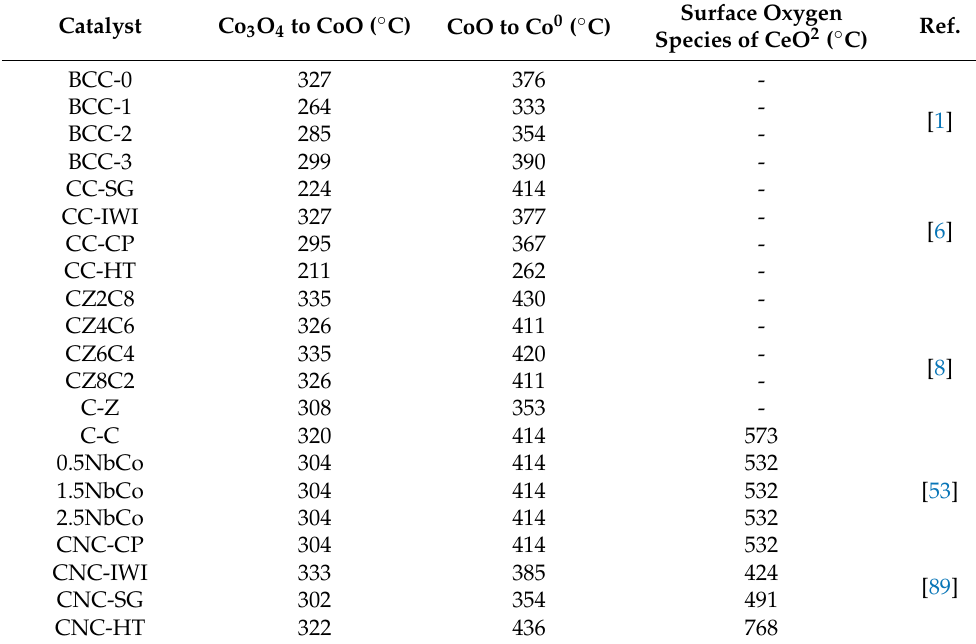
Table 9. Reduction characteristics of Co-based catalysts.